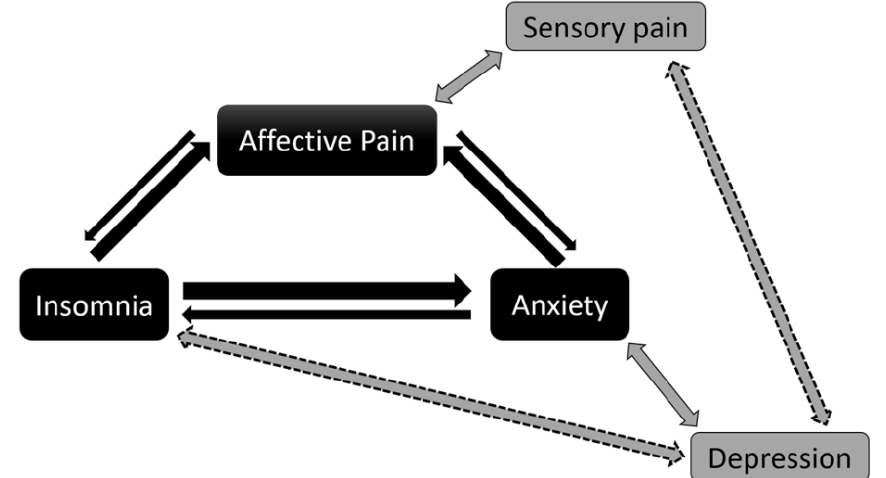
Figure 3. Affective pain–insomnia–anxiety loop and the role of ongoing pain intensity. The main constituents of the loop are labeled in black: affective pain, insomnia, and anxiety. Similarly, black arrows show their relationship, with the main direction being indicated by thicker arrows. Insomnia directly relates to affective pain but also through anxiety. Thus, all main arrows point to affective pain. The reverse relationship, although existing, is not favored by currently available data (narrower black arrows). Sensory pain is correlated to affective pain, and not to insomnia or anxiety, while depression is solely related to anxiety. These links seem to be out of the loop (grey boxes and arrows). In the presence of significant ongoing pain (VAS ≥ 3), not only does the correlation between insomnia and anxiety increase (not shown), but a new correlation appears on one hand between sensory pain and depression, and on the other hand between insomnia and depression (dashed grey arrows). Thus, high pain appears not only to reinforce the loop, but also to put into play other clinical factors that primarily appeared not to be involved in the loop (i.e., depression and sensory pain).